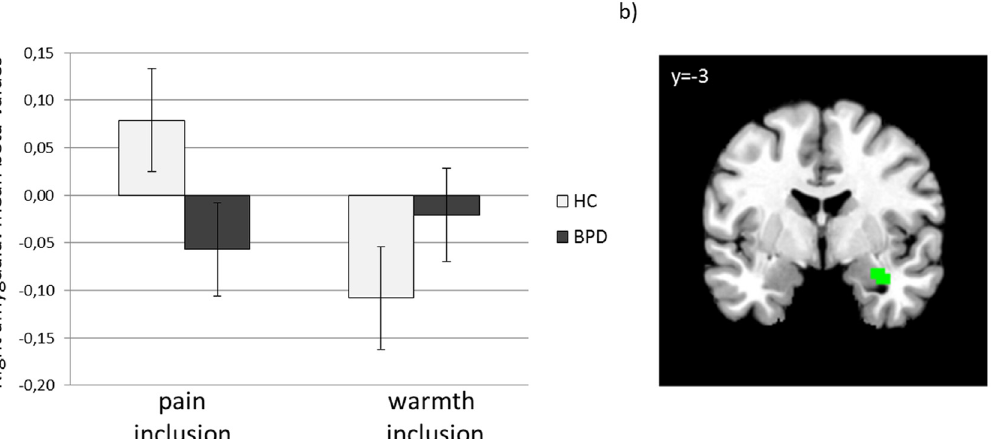
Fig 3. Mean amygdala activation during painful compared to non-painful stimuli following social inclusion. a) mean beta values of peak voxel activation for HC and BPD, b) visualization of reduced amygdala activation in BPD compared to HC during painful compared to non-painful stimuli following social inclusion (Threshold for display: p < 0.005